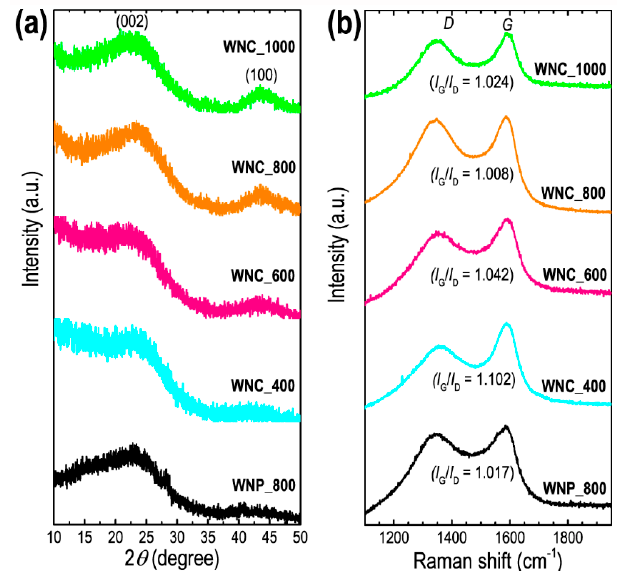
Figure 4. ( a ) Powder X-ray diffraction (pXRD) patterns of WNP_800, WNC_400, WNC_600, WNC_800, and WNC_1000 recorded at 25 °C, and ( b ) Raman scattering spectra of WNP_800, WNC_400, WNC_600, WNC_800, and WNC_1000 recorded at 25 °C.